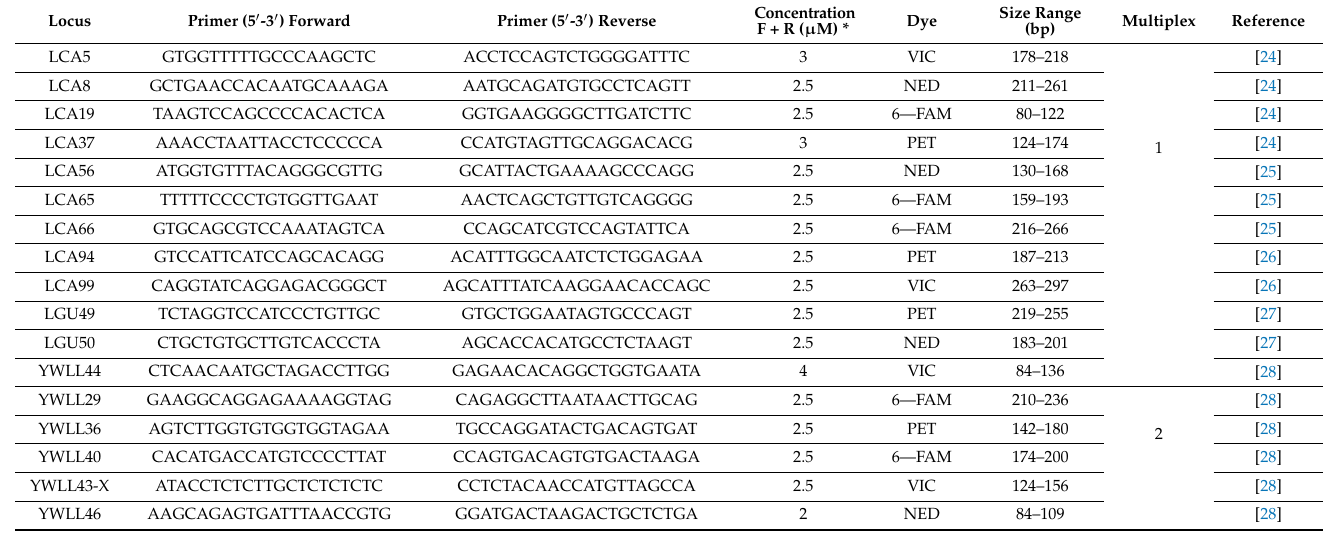
* Concentration of forward and reverse primer in primer mixture. All microsatellites were